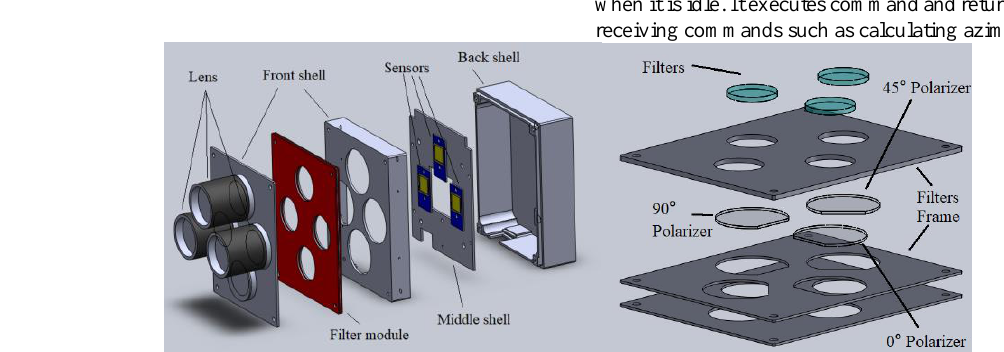
Figure 2. The opto-mechanical structure of the